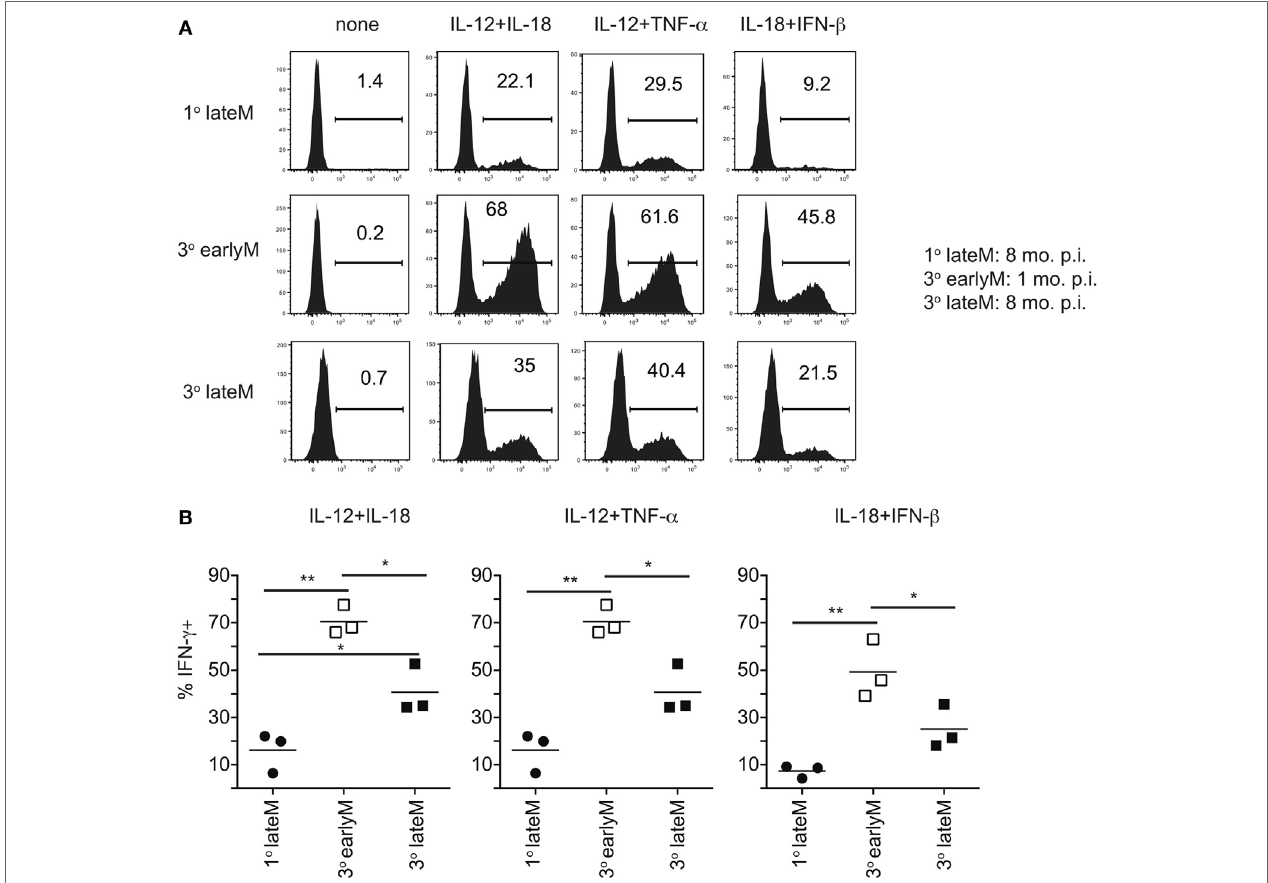
FigUre 6 | IFN- γ production in response to inflammatory cytokines decreases with time after initial antigen encounter for 3° memory CD8 T cells. Mice received adoptive transfer of naïve or 2° memory P14 cells and were infected with LCMV-Armstrong. 30 days (3° earlyM) or > 8 months (1° lateM and 3° lateM) after LCMV infection, splenocytes were harvested and incubated for 4 h with 10 ng/mL each of rIL-12 and IL-18, IL-12 and TNF- α , or IL-18 and IFN- β in the absence of Brefeldin A and for 1 additional hour in the presence of Brefeldin A. (a) Representative histograms of IFN- γ production by 1° lateM (top), 3° earlyM (middle), or 3° lateM (bottom) P14 cells incubated with the indicated combinations of inflammatory cytokines. (B) Summary graphs of the percentage of 1° lateM, 3° earlyM, or 3° lateM P14 cells producing IFN- γ following incubation with the indicated combinations of inflammatory cytokines. n = 3 mice/group. Representative data from one of three independent experiments. Bars represent mean. ANOVA with Bonferroni posttest; * p < 0.05, ** p <